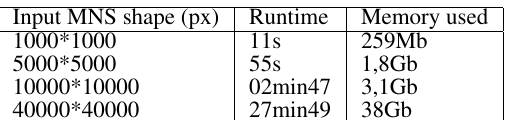
Table 1. Bulldozer runtime statistics according to the input DSM size. Execution environment: 16 CPU, 60GB RAM with Float32 input DSM. Bulldozer configuration: max object size = 16 , n outer = 100 , n inner = 10 , filled DSM = True